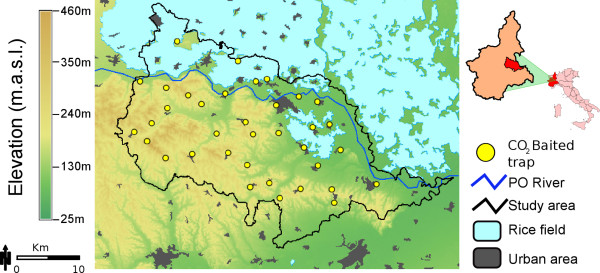
Map showing the location of the 36 mosquito trapping locations together with topographic and environmental attributes of the study area. Inset shows the location of the study area within the Piedmont region and Northern Italy.